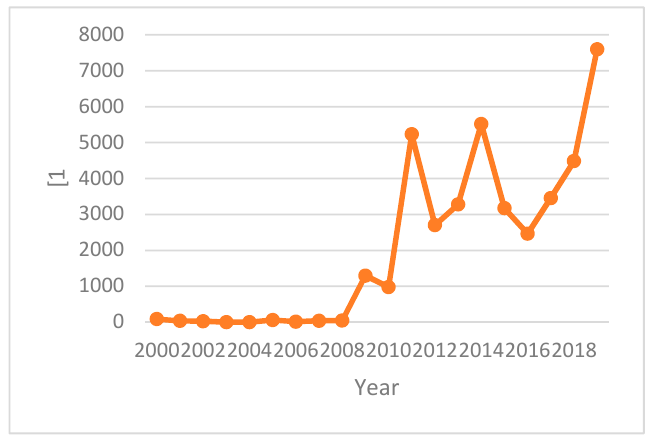
Figure 6. China’s yearly import of corn, 2000–2019 3 .